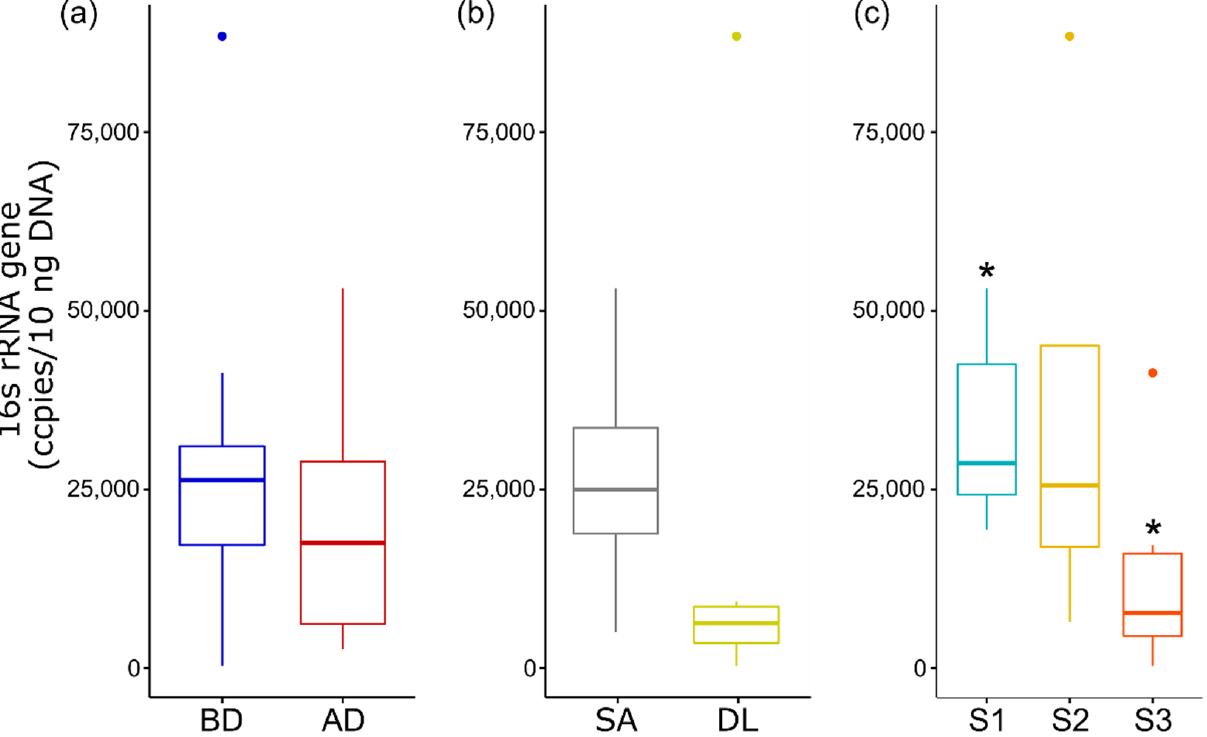
Figure 7. The total bacterial load of eggs from the three aquaculture sites quantified by qPCR of 16S rRNA. The box plots represent the different variables: ( a ) disinfection—before disinfection (BD) and after disinfection (AD); ( b ) species—gilthead seabream (SA) and European seabass (DL); ( c ) site—site 1–3. * Significance code: at p < 0.05.